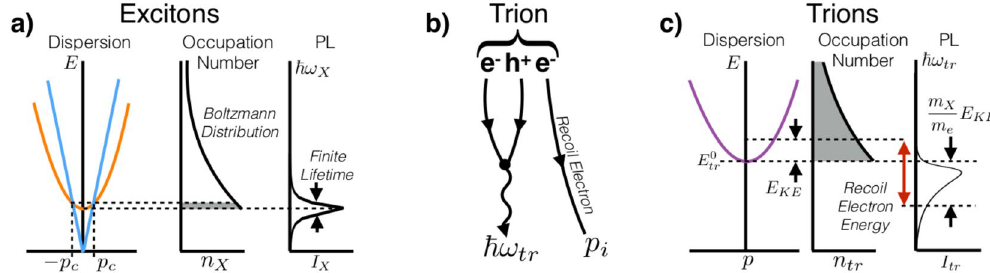
Figure 2. ( a ) The exciton dispersion is shown in orange and photon dispersion in blue with exaggerated momentum, ~200 × , to make the light cone visible. Only excitons within the light cone, | p | < p c , can radiatively decay. This population is highlighted in the narrow, delta function like region in the occupation number plot, which results in a Lorentzian shaped PL. ( b ) The Feynman diagram for trion radiative decay. One of the electrons recombines with the hole to emit a photon while the other electron is kicked out to conserve energy and momentum. ( c ) The trion dispersion is shown in purple with the zero-momentum and kinetic energies of a trion denoted. All trion states can radiatively decay, so all states in the occupation plot are allowed optical transitions. To convert from the occupation distribution to the PL, we must account for the energy of the recoil electron resulting in the long low-energy